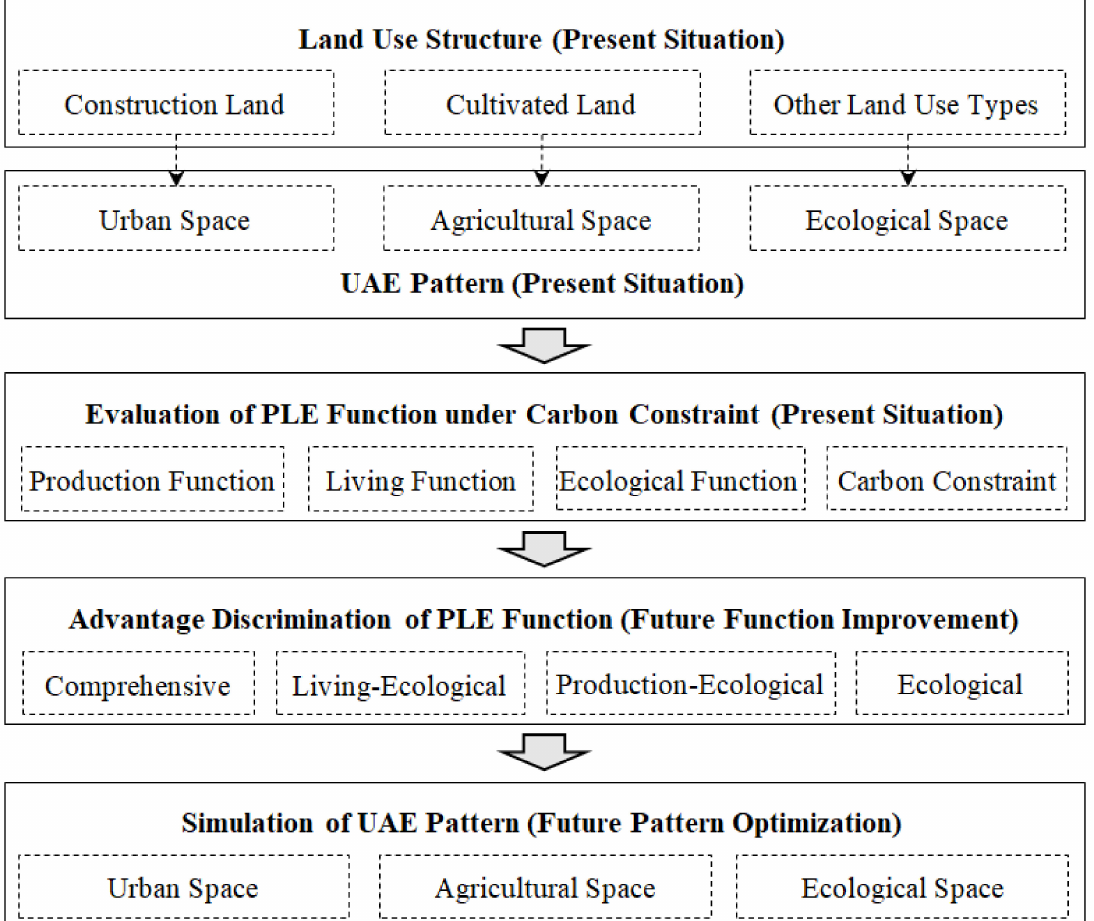
Figure 1. Conceptual